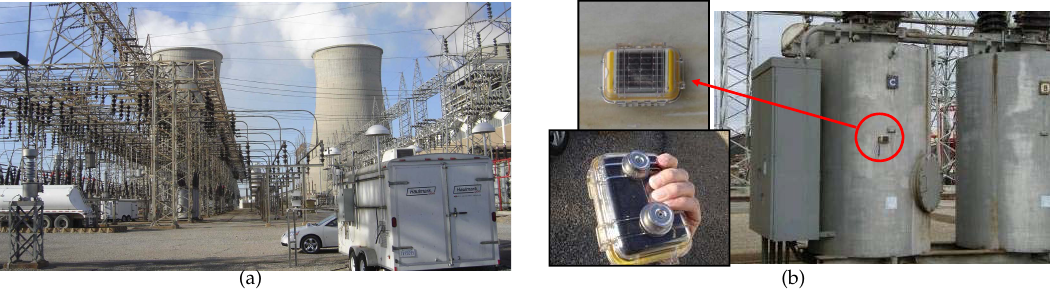
Figure 2. ( a ) View of the Paradise substation, where the ParadiseNet was deployed; ( b ) One of the wireless sensor nodes for circuit-breaker